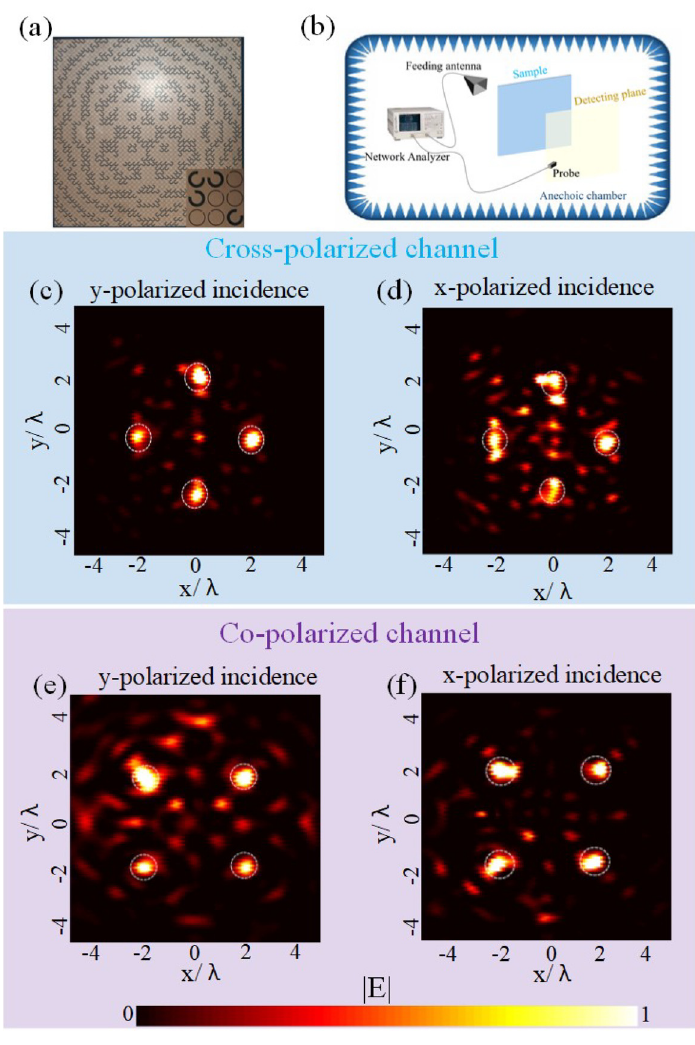
Figure 4: (a) Photography of fabricated sample. (b) Illustration of experimental setup. (c) and (d) Measured holographic “ rhombus ” images of the cross-polarized channel under y - and x -polarized incidence, respec- tively. (e) and (f) Measured holographic “ square ” im- ages of the co-polarized channel under y - and x -polarized incidence,